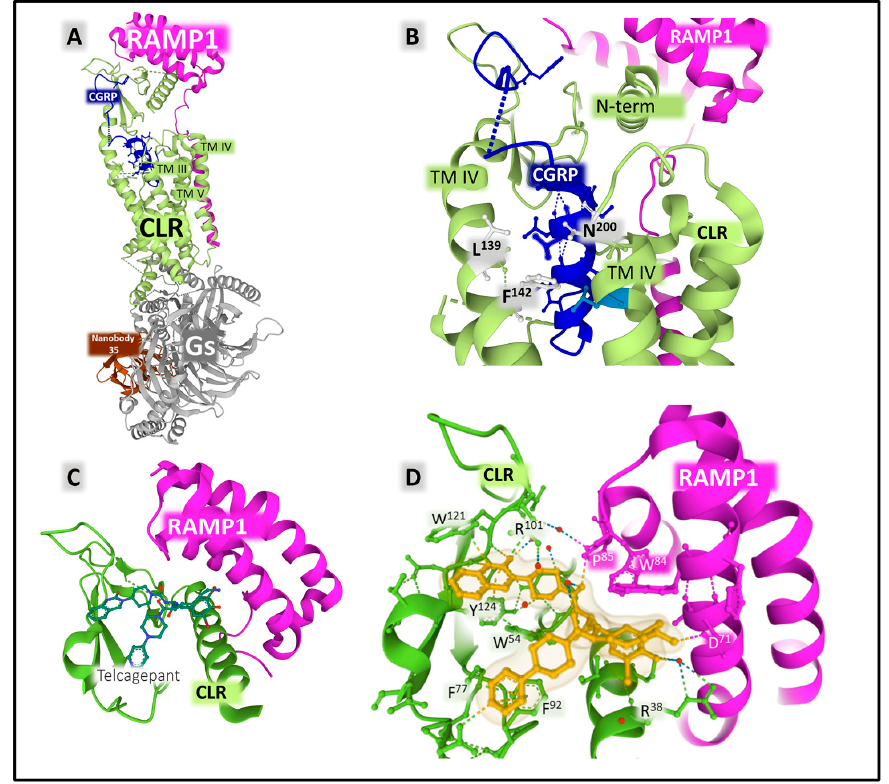
Figure 10. ( A ) shows the crystal complex formed by CLR (calcitonin receptor-like receptor in green) bound to protein RAMP1 (receptor activity modifying protein, in pink), Gs heterotrimeric protein (gray), and nanobody 35 (brown). The interaction of RAMP 1 with the transmembrane segments III, IV, and V and the N-terminal portion of CLR are indicated in the figure. ( B ) depicts the binding site of CGRP (calcitonin gene-related peptide, blue), showing the amino-acid posi- tions of CLR contacting the agonist peptide. ( C ) shows the crystal structure of an ectodomain complex of the CGRP receptor bound to the antagonist telcagepant (MK0974). ( D ) highlights the contacts between the antagonist and the receptor structure. The figures mark the position of transmembrane (TM) helices. Dashed lines indicate weak interactions stabilizing peptide struc- ture. The representations in ( A , B ) corresponding to PDB ID 6E3Y [123], and those in ( C , D ) cor- responding to PDB ID 3N7S [127] were obtained from the Protein Data Bank (PDB [65]) and colored with Mol* free web-based software [71]. A crystal structure of the ectodomain of the CGRP receptor bound to the selective antagonist telcagepant revealed the interactions between the antagonist compound and the lateral chains of amino acids from RAMP1 and CLR (Figure 10C,D) [127]. Telcagepant and olcegepant exert their antagonistic effect by disrupting the access of the endogenous peptide agonist to the binding site located in the interphase between CLR and RAMP1 [127]. Structural studies also revealed the binding of antibodies to halt CGRPR action. Erenubab is a monoclonal IgG antibody approved by the US FDA (Federal Drug Ad- ministration) for the treatment of migraine. The antibody is highly selective and potent, and it exhibits full antagonism for the CGRPR [128]. X-ray crystallography and func- tional studies [129] determined the interaction of erenumab with the receptor complex (Figure 11). Several regions of the light and heavy chain of the antibody, named CDRs (complementary determining regions), are in close contact with the interface between CLR and RAMP1. Given its conformational plasticity, region CDRH3 in the heavy chain, including residues 99 to 119, represents a key sequence responsible for receptor